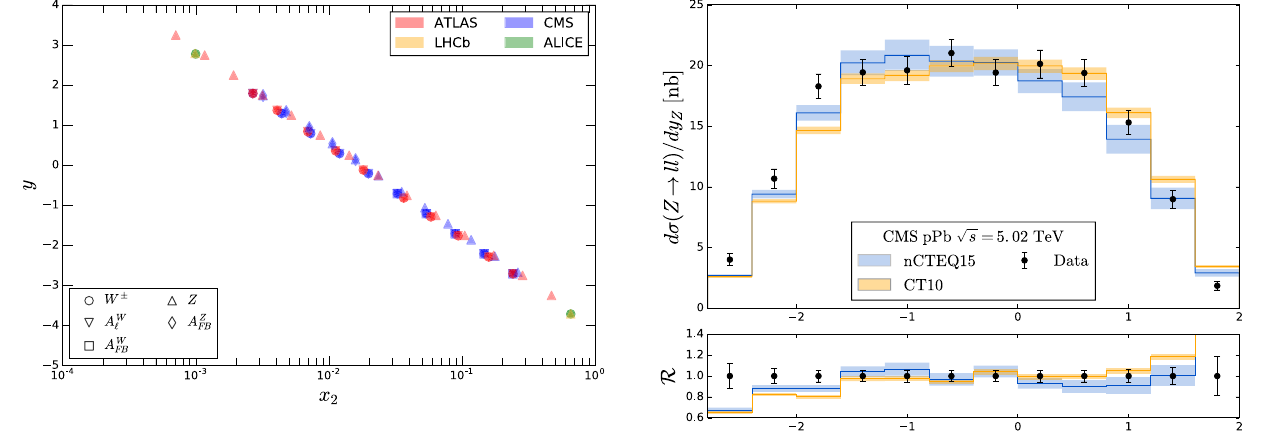
Fig. 2 Range of the pPb data used for reweighting. y is rapidity in the CM frame and x 2 is momentum of the parton from the lead beam